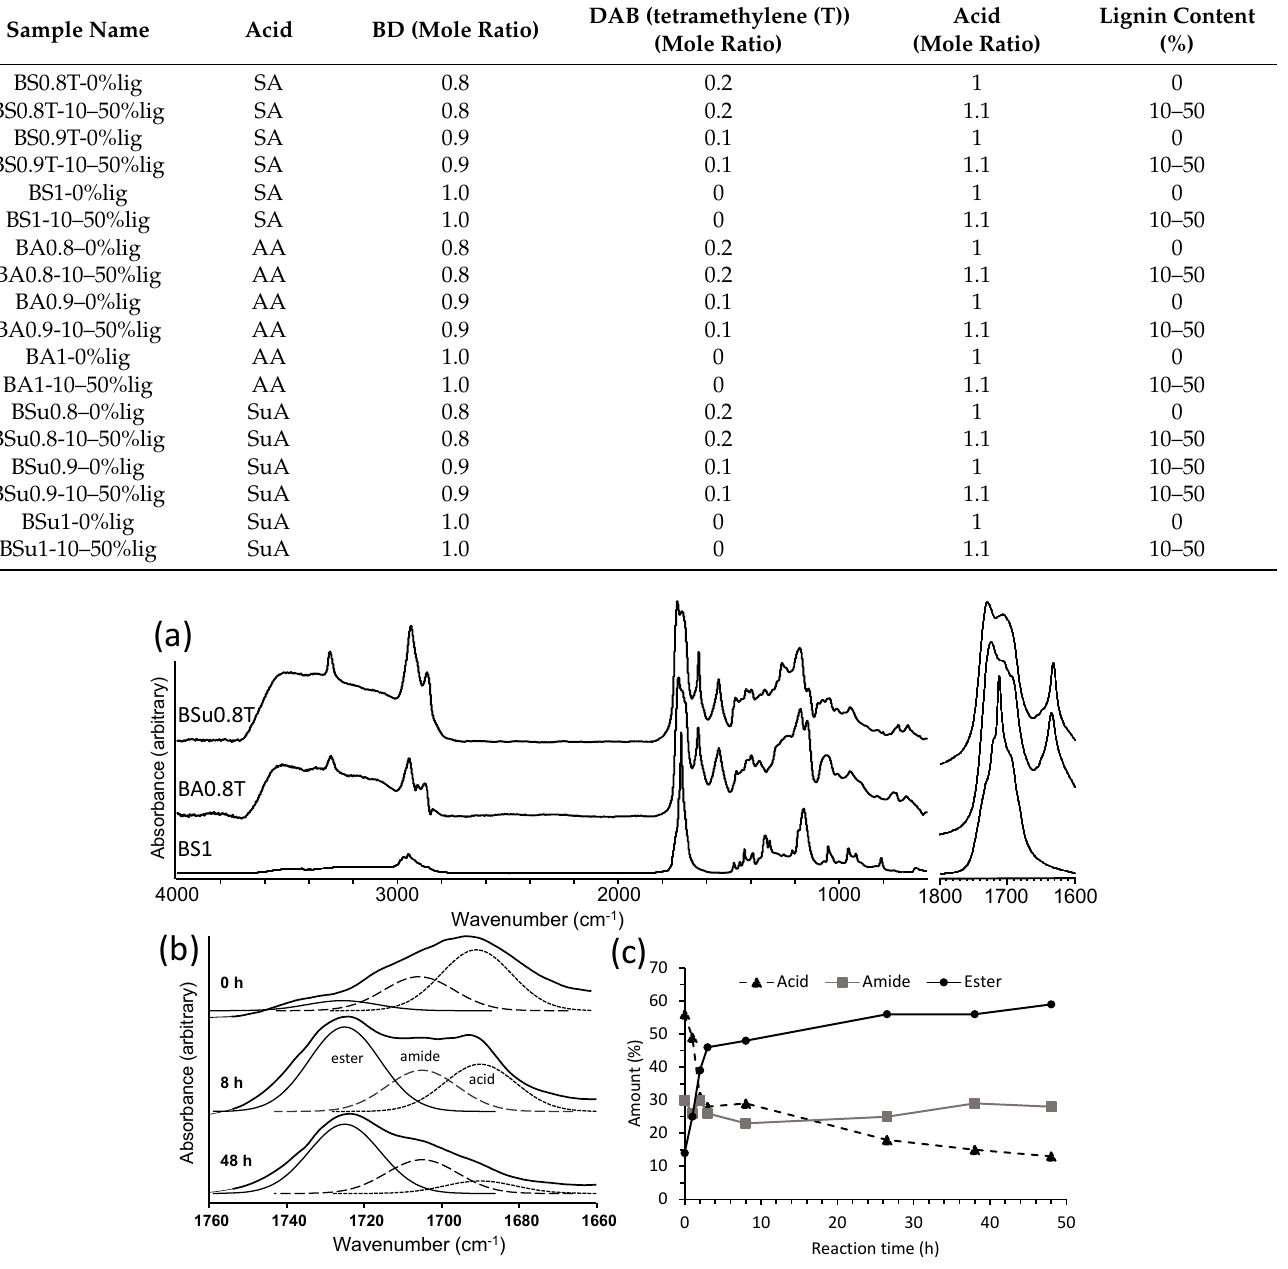
Figure 2. ( a ) FTIR spectra plus expanded carbonyl region of the prepolymers BA0.8T, BS1 and BSu0.8T at 3 h reaction, ( b ) FTIR spectra of the carbonyl region at 0, 8 and 48 h for the prepolymer BA0.8T and ( c ) plot of acid, ester and amide carbonyl stretching bands amount with reaction time for the prepolymer BA0.8T.